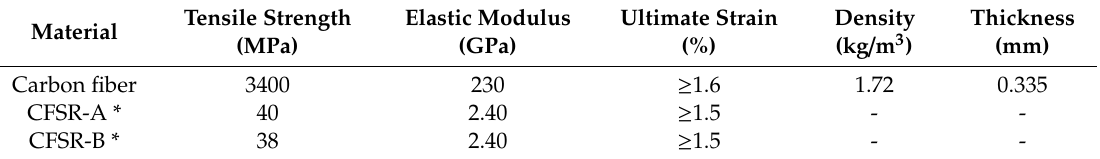
Table 3. Properties of carbon fiber-reinforced polymer